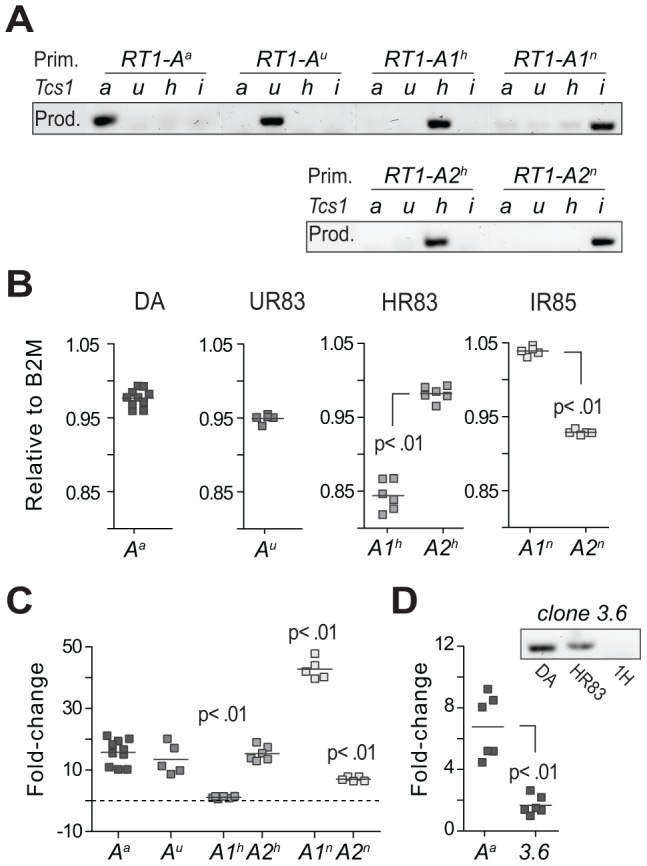
Transcriptional regulation of MHC class I genes.(A) Allele-specific primers (Prim.) used for quantitative RT-PCR showed minimal amplification of other RT1-A alleles and were therefore considered class Ia-specific (i.e. not cross-reacting to class Ib genes); PCR products (Prod.) are shown for DA (a), DA.1UR83 (u), DA.1HR83 (h) and DA.1IR85 (i). (B) Expression in spleen of RT1-A genes in DA and Tcs1-congenic strains relative to the expression of beta-2-microglobuline (B2M). (C) Variation (fold-change) in RT1-A gene expression between different congenic strains. Data show the mean expression of 2–4 different primer sets per target gene after normalization to 3 reference genes (Table S3). Significant differences compared to RT1-Aa. (D) Expression of RT1-Aa (class Ia) and clone 3.6 (class Ib) in spleen from DA rats. The amplification of a product in DA.1HR83 but not in DA.1H (1H) indicates that the primers for clone 3.6 are not cross-reacting to the RT1-Aa gene in DA (adjacent figure).